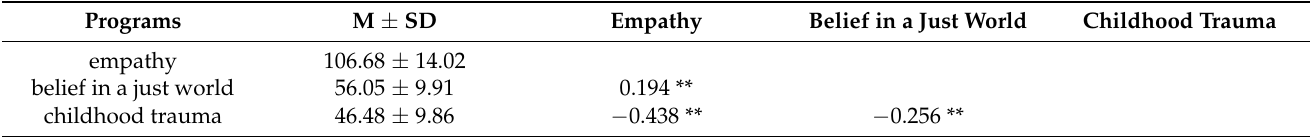
Table 1. Correlation analysis of empathy, belief in a just world, and childhood